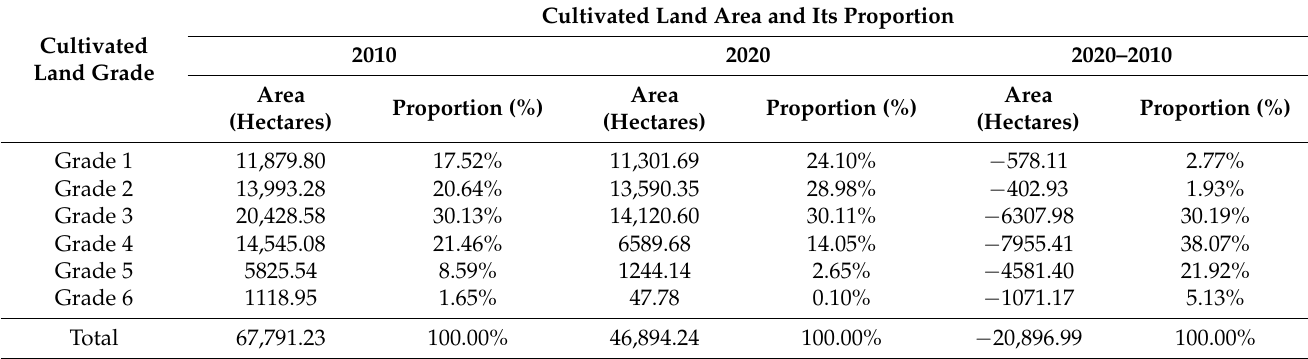
Table 5. Area and proportion of cultivated land quality of different quality grades,